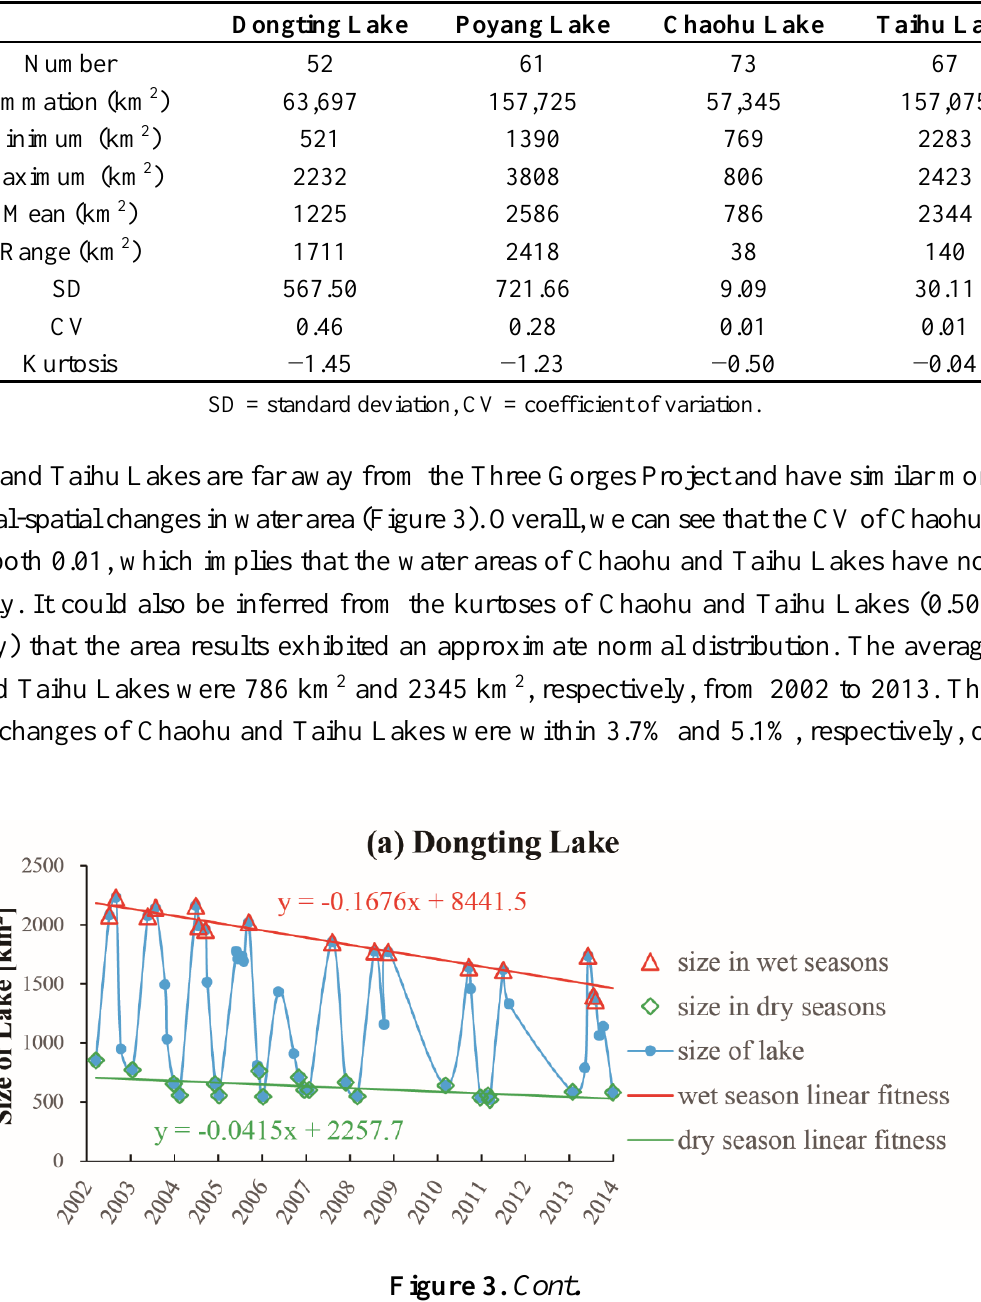
Table 2. Statistical description of four lake extraction areas in southeastern